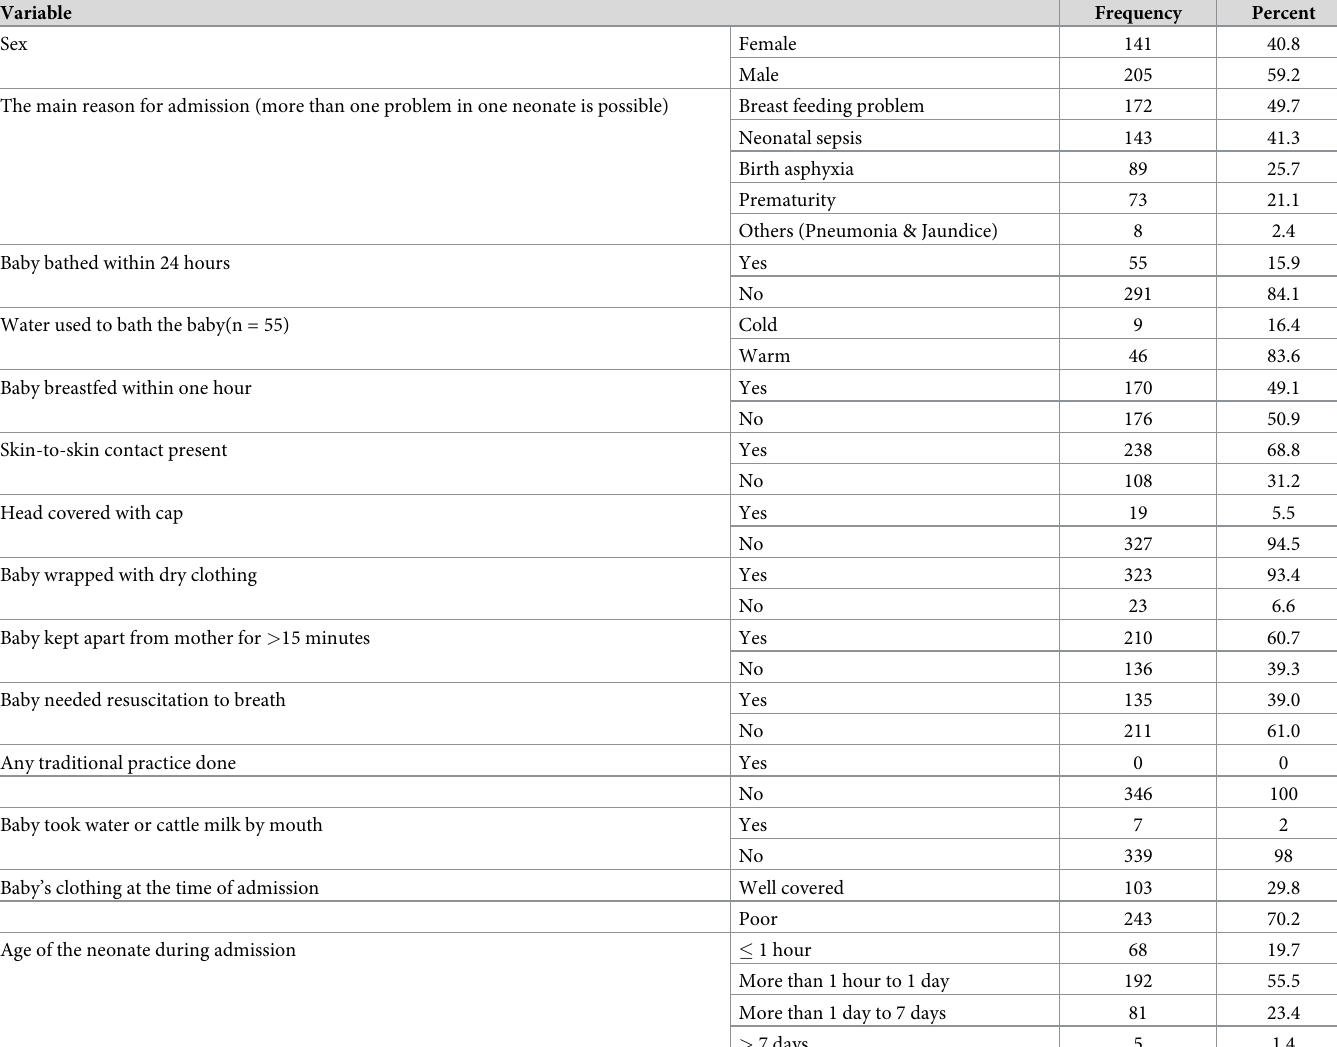
Table 4. Characteristics of the neonates admitted to NICUs in Arba Minch and Jinka general hospitals, Southwest Ethiopia, 2017 (n =